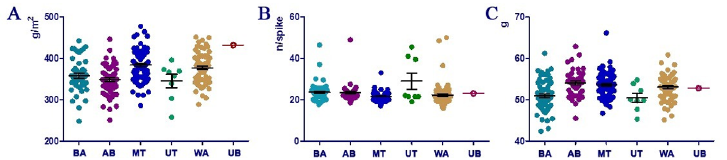
Fig 3. Comparisons between barley accessions from five breeding institutions of the USA and the standard Kazakh cultivar Ubagan (UB) at the Karabalyk breeding station, Northern Kazakhstan. Bars denote 95% confidence intervals. MT–Montana State University, WA–Washington State University, UT–Utah State University, AB–Small Cereal Collection of the USDA held in Aberdeen (Idaho), BA–Busch Agricultural Resources, a division of the Anheuser-Busch Corporation. A. Grain yield per m2 (YM2). B. Number of kernels per spike (NKS). C. Thousand grain weight